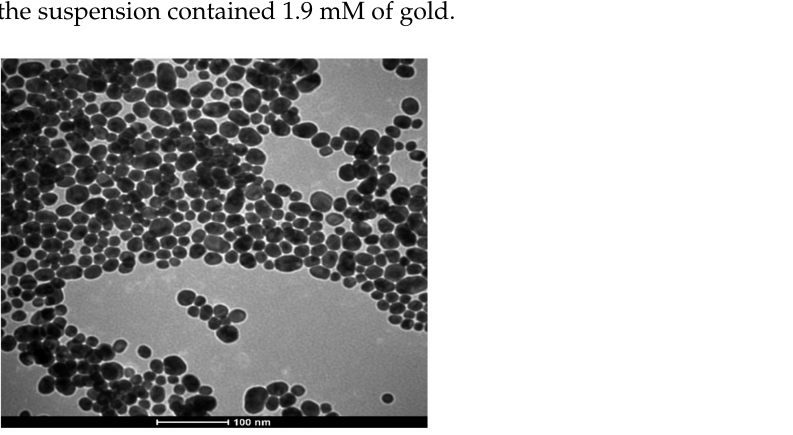
Figure 2. TEM image of